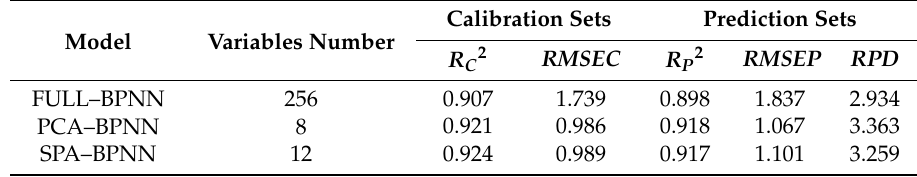
Table 1. Performance results based on different regression